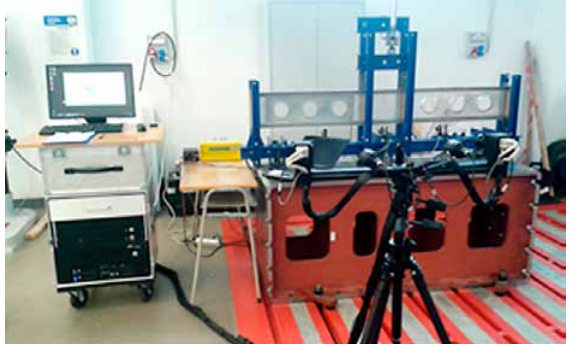
Fig. 2. Specimen in the test jig before the test Fig. 4. Position of strain gauges (view on side